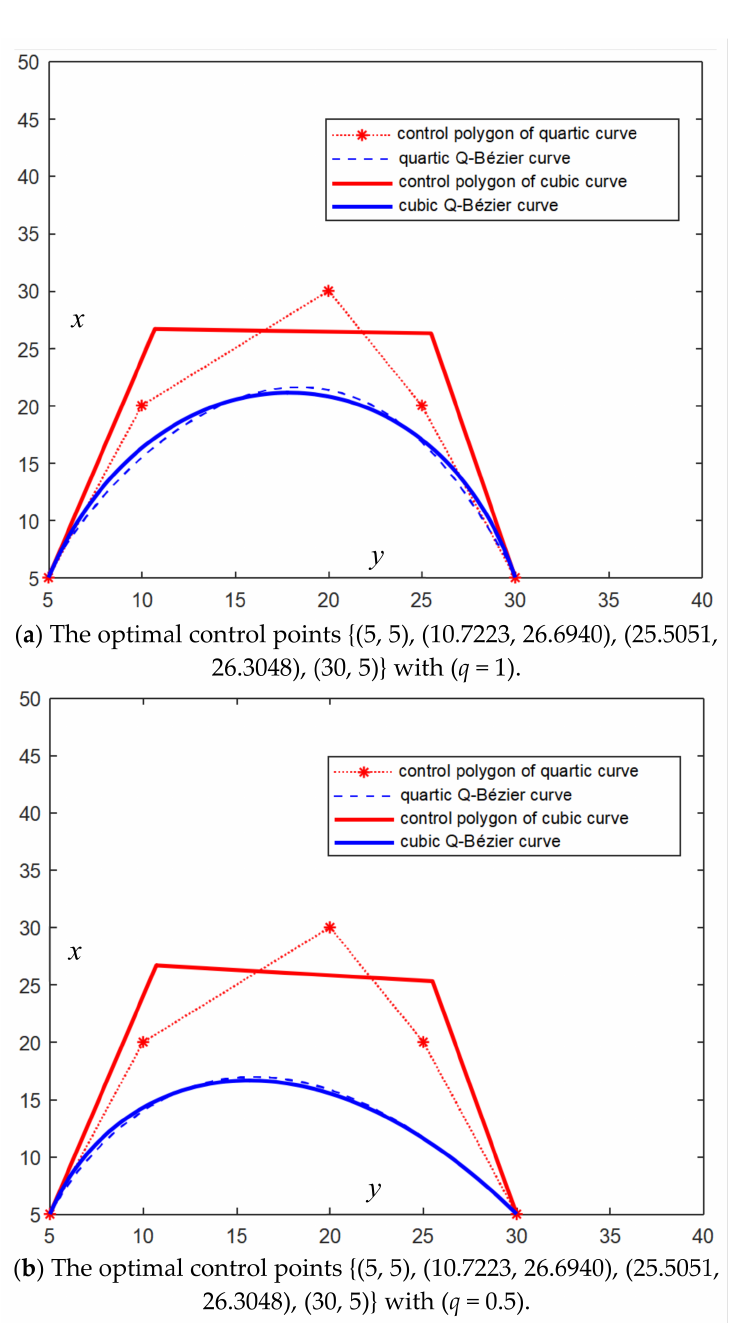
Figure 3. One-degree reduction of a quartic Q-B é zier curve with the shape parameter q = 1,